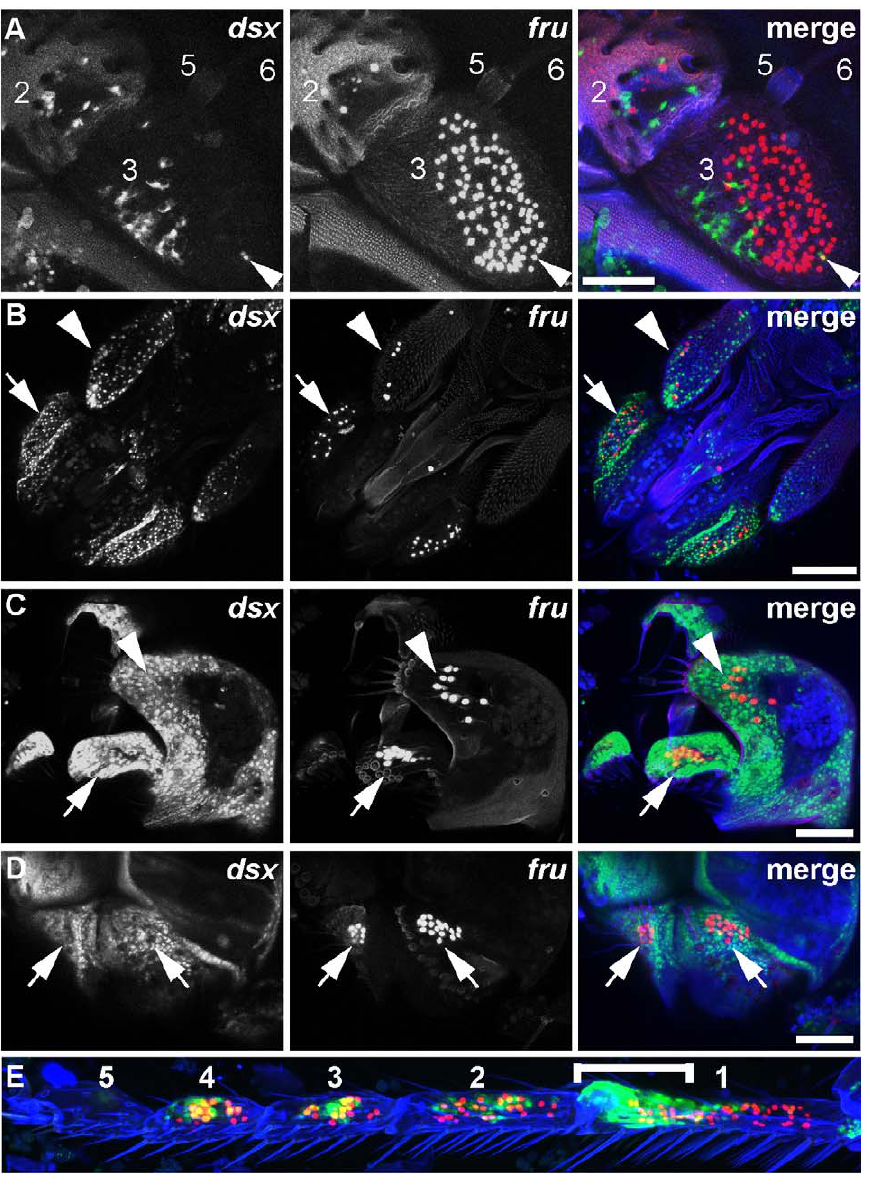
Figure 6. dsx GAL4 and fru P1.LexA expression in peripheral sensory structures. Expression of dsx GAL4 and fru P1.LexA at 72 h APF. In the fru P1.LexA chromosome, LexA::VP16 coding sequence followed by the SV40 poly-A signal and a -tubulin 3 9 UTR sequences as transcriptional termination sequences were inserted into the fru gene [50]. dsx GAL4 was detected by expression of UAS-Stinger nuclear GFP reporter (green), and fru P1.LexA was detected by expression of lexAop-tdTomato::nls (red). Cuticle autofluorescence is in blue. Confocal Z projections are shown. (A) In the antenna, dsx GAL4 is expressed in a subset of cells that are largely distinct from the population of neurons expressing fru P1.LexA . In segment 2, cells near the base of the large mechanosensory bristles express dsx GAL4 . In segment 3, the majority of cells expressing dsx GAL4 lie close to the cuticle and do not have a neuronal morphology. Neurons expressing both genes (yellow) were rarely observed (arrowhead). Female antenna shown. Scale bar, 50 m m. (B) In the proboscis and maxillary palps, no cells express both dsx GAL4 and fru P1.LexA . (Nonspecific overlap is artifact of Z projection.) At the tip of the maxillary palp (arrowhead), dsx GAL4 is expressed in cells near the base of the large mechanosensory bristles. In the maxillary palps and the proboscis (arrow), there are many pericuticular dsx GAL4 -expressing cells. Female structures shown. Scale bar, 100 m m. (C) In the male external genitalia, dsx GAL4 is broadly expressed in pericuticular cells, as well as in neurons of the claspers (arrow), which also express fru P1.LexA . dsx GAL4 is not expressed with fru P1.LexA in neurons of the lateral plates (arrowhead). The genitalia are viewed from a side angle, and anterior is up. Scale bar, 50 m m. (D) In the paired male anal plates, dsx GAL4 is broadly expressed in pericuticular cells (arrows) but is not co-expressed with fru P1.LexA in mechanosensory neurons. The analia lie posterior to the genitalia and are viewed from a side angle. Scale bar, 50 m m. (E) Tarsal segments T1–T5 of the male foreleg. The tarsal segments are numbered 1–5, proximal to distal. Expression of dsx GAL4 is seen in a subset of fru P1.LexA -expressing neurons associated with gustatory sense organs, most visible in segments 3 and 4. Pericuticular expression is seen in the region of the sex comb (bracket). (Overlap in tarsal segment 5 is not visible in this projection.)